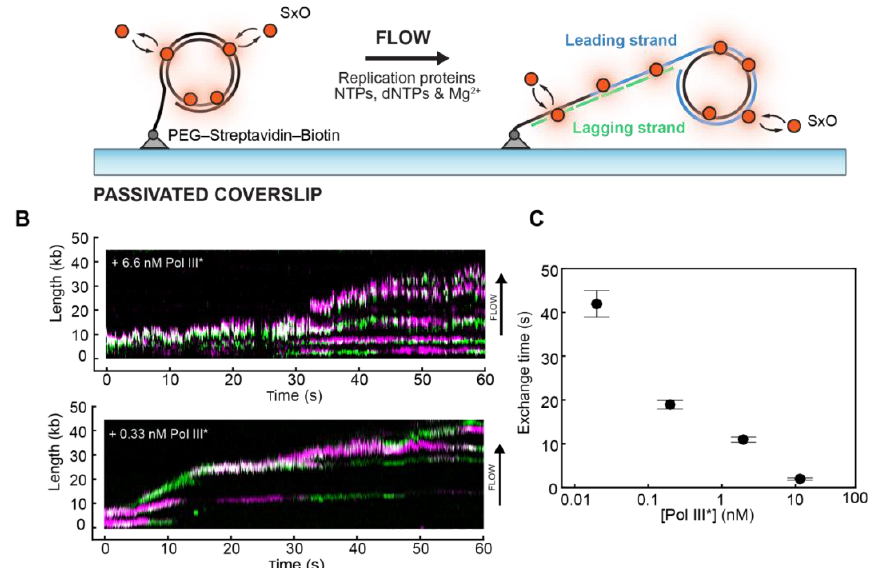
Figure 5. Visualisation of replisome dynamics during DNA replication. ( A ) Cartoon representation of the single-molecule rolling-circle replication assay. A 5′-biotinylated circular DNA molecule is coupled to the surface of a passivated microfluidic flow cell through a streptavidin linkage. Addition of replication proteins and deoxyribonucleotide triphosphates (dNTPs) initiates DNA synthesis. The DNA products are elongated hydrodynamically by flow, labelled with SxO and visualised using fluorescence microscopy. ( B ) Rapid and frequent exchange of Pol III* (holoenzyme lacking the β 2 sliding clamp) is concentration-dependent. Representative kymographs of the distributions of two different fluorescently labelled Pol III* (magenta and green) on individual DNA molecules at different concentrations. ( C ) Exchange times as a function of Pol III* concentration (reproduced with permission from